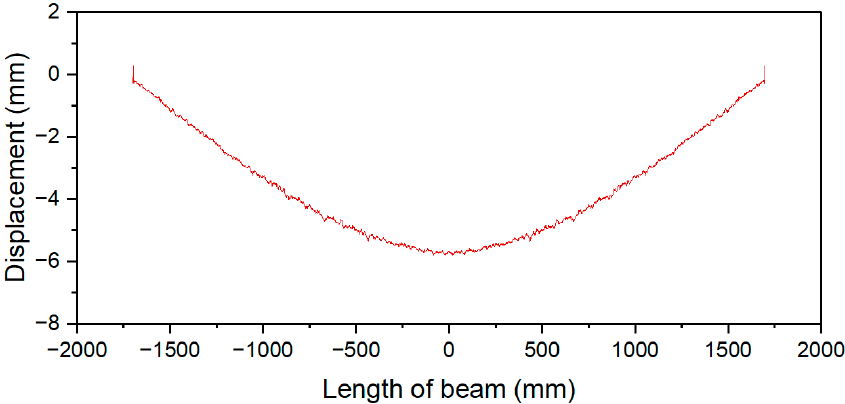
Figure 11. Deflection line created in the DIC system.